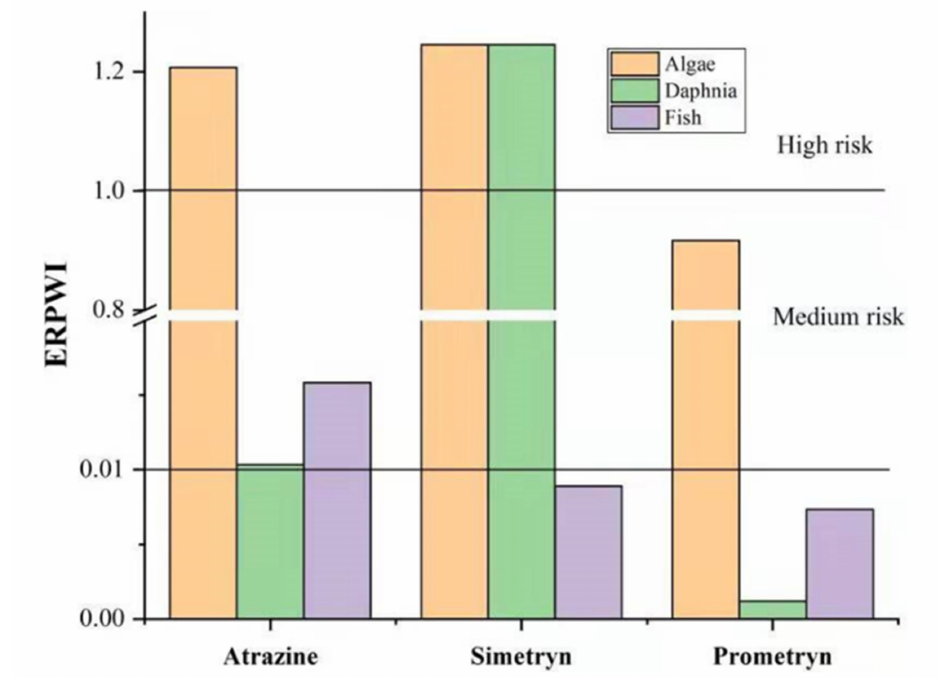
Figure 2. ERPWI values of the herbicides on the three aquatic